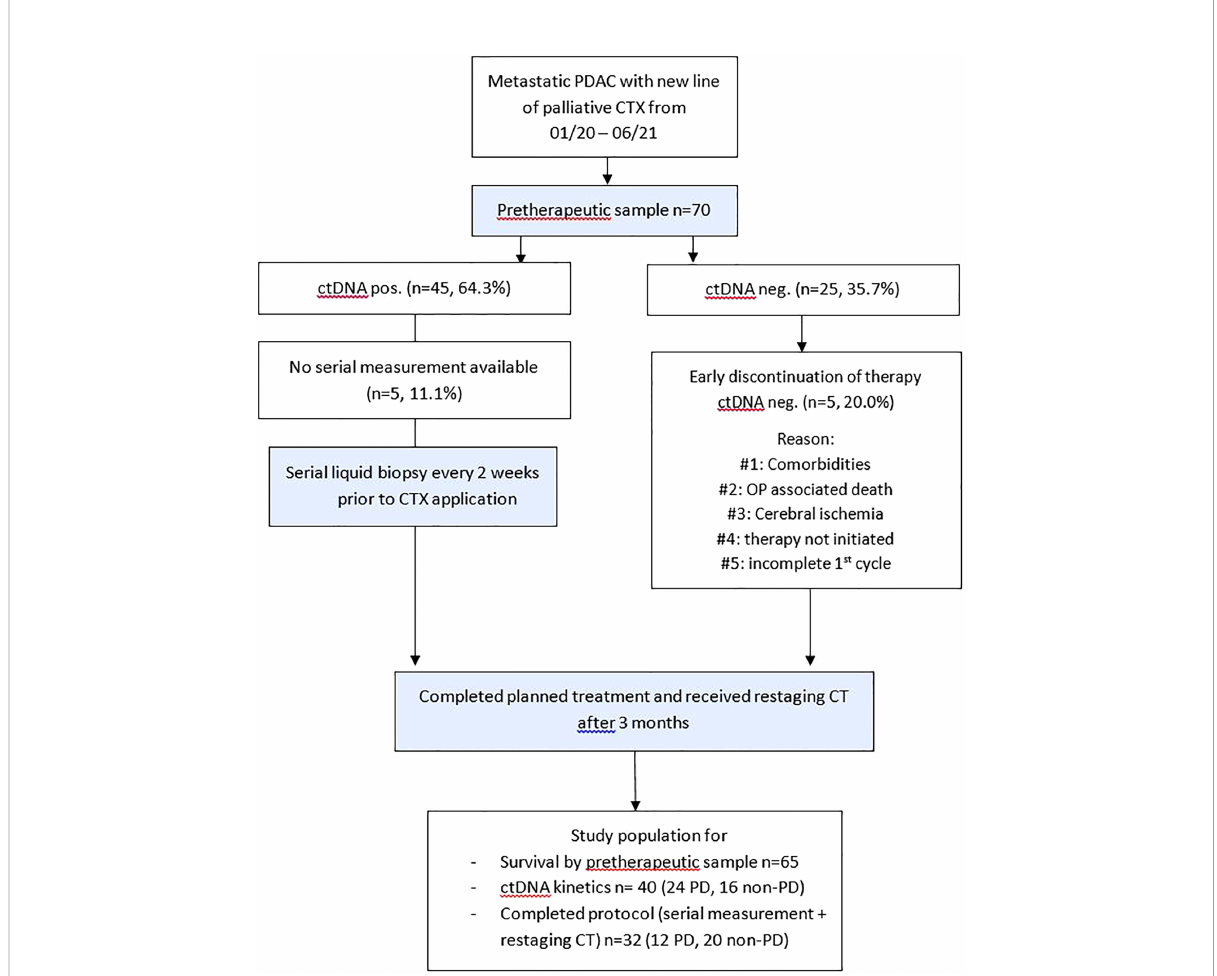
FIGURE 1 Study fl ow diagram. Patients with metastatic PDAC and planned application of a new line of palliative chemotherapy were included. CT, computed tomography; ctDNA, circulating tumor DNA; CTX, chemotherapy; neg., negative; non – PD, non – progressive disease (complete response, partial response, stable disease); OP, operation; PD, progressive disease; PDAC, pancreatic ductal